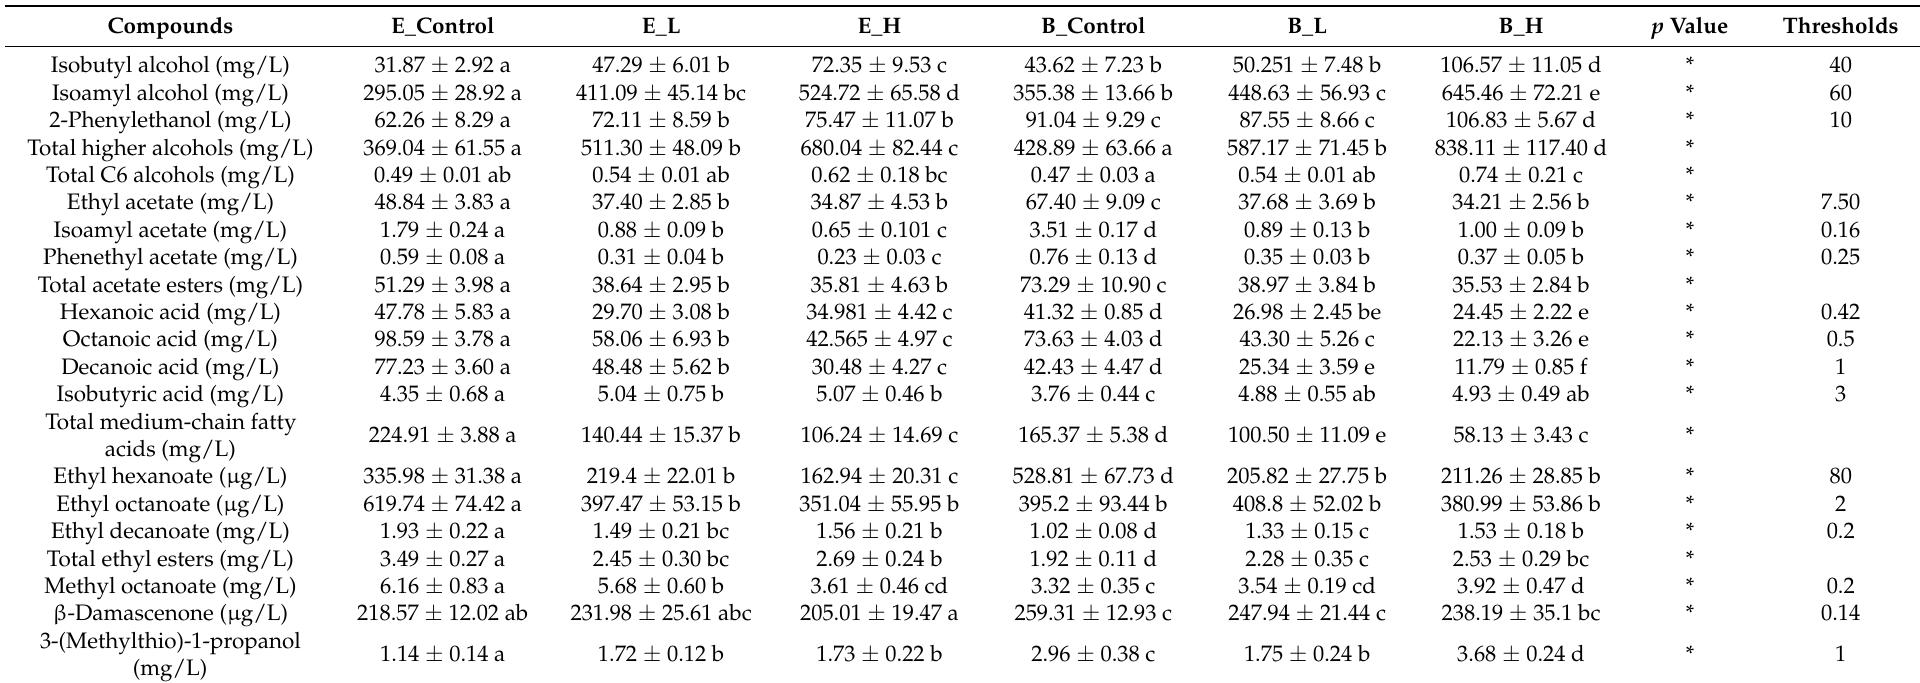
Table 2. Effects of different levels of UFAs mixtures on volatile compounds (OAV > 1) and total concentrations of higher alcohol, esters, and medium-chain fatty acids in wine after alcoholic